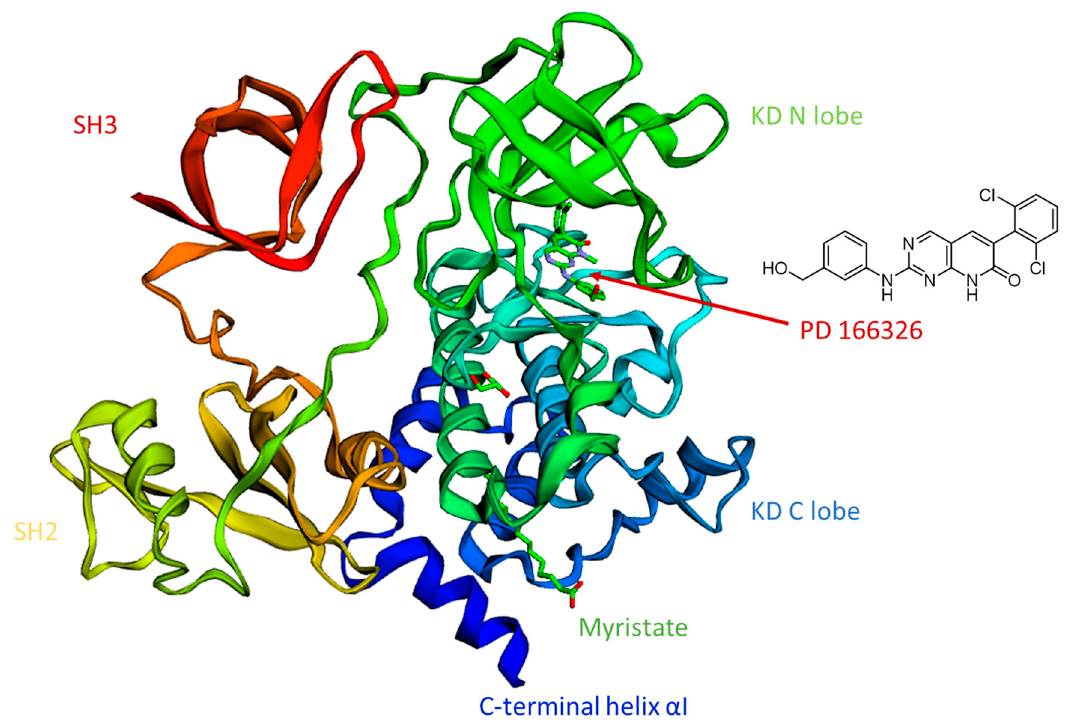
Figure 2. Auto-inhibited Abl in complex with the ATP competitive inhibitor PD166326 and myristate (PDB entry, 1OPK [20,27]).